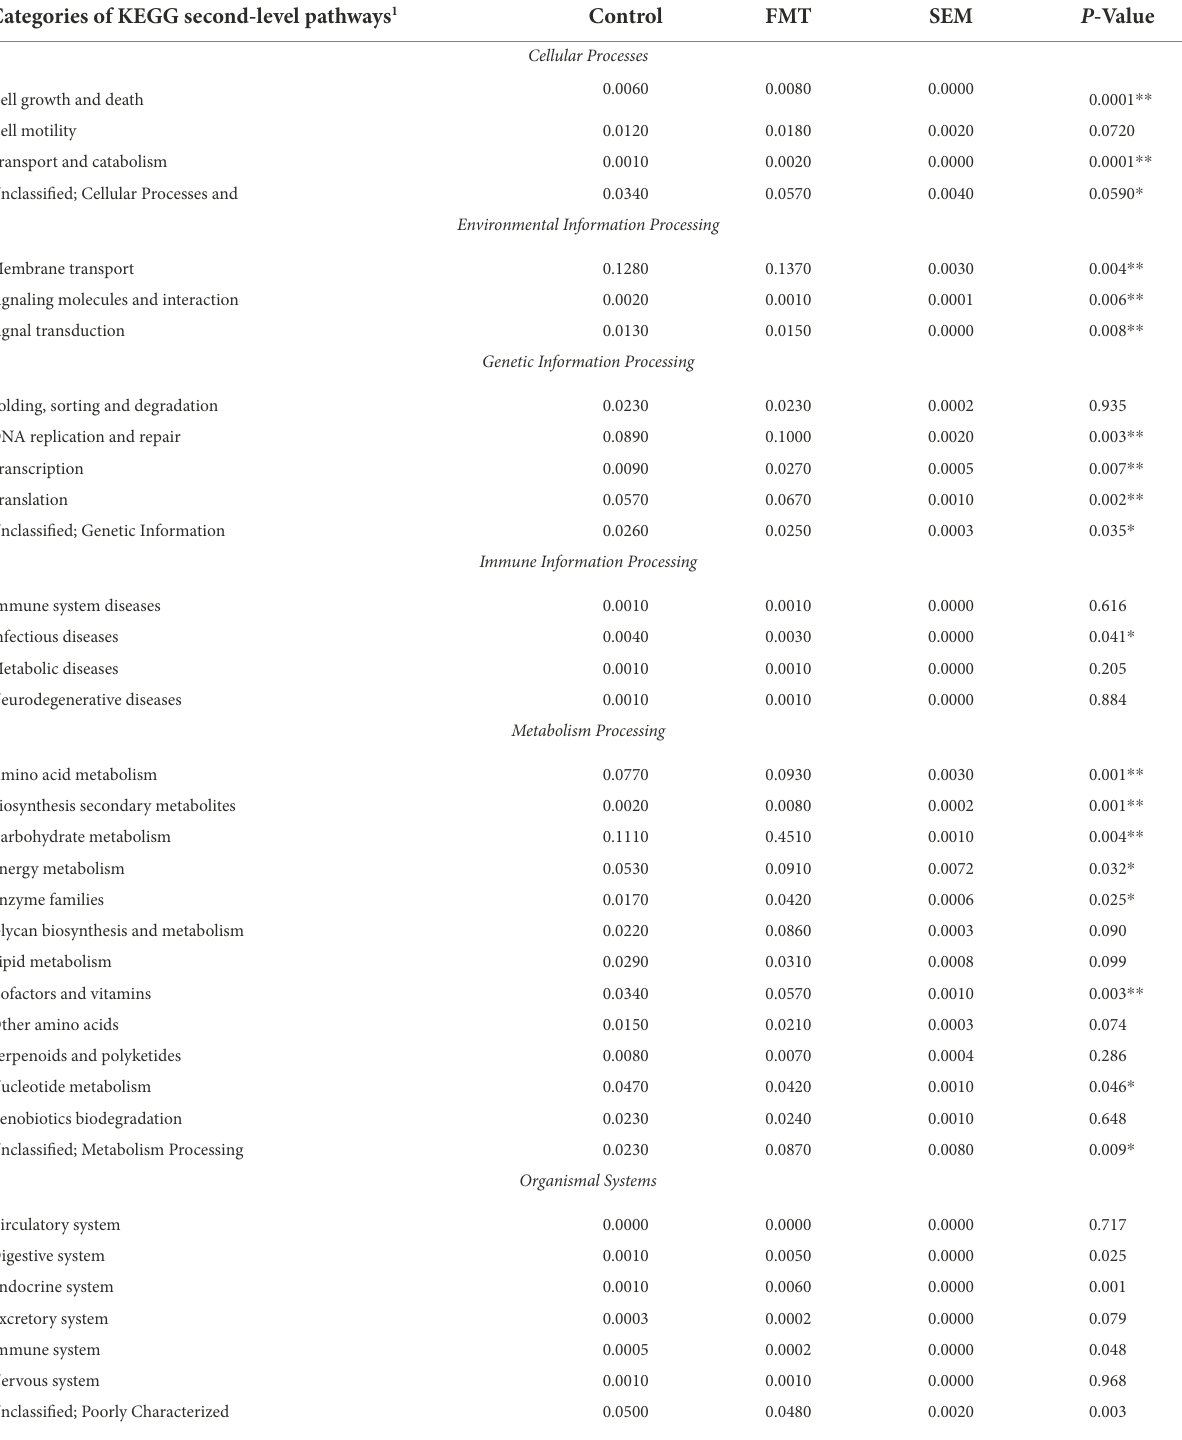
TABLE 5 Relative abundance of the functional microbiome predicted by KEGG second-level pathways between chicks from the control and FMT groups estimated using the statistical analysis of metagenomic